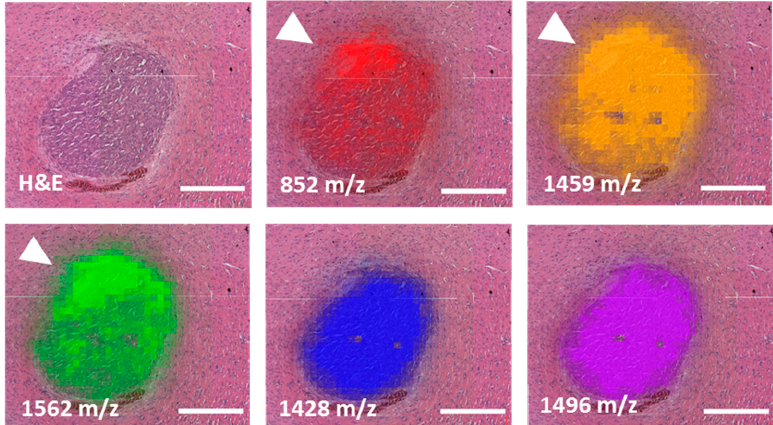
Figure 3. Intensity maps and blots of mass 1586.8 m/z (upper part: green; lower part: marked with *) in three representative U87MG_mCherry tumors indicate an extension and increase of the mass beyond the tumor margins after irradiation with 3 fractions of 3 Gy within the irradiated volume (arrows, ( A / D ) + ( B / E )), in contrast, no expansion can be seen in untreated tumors ( C / F ).